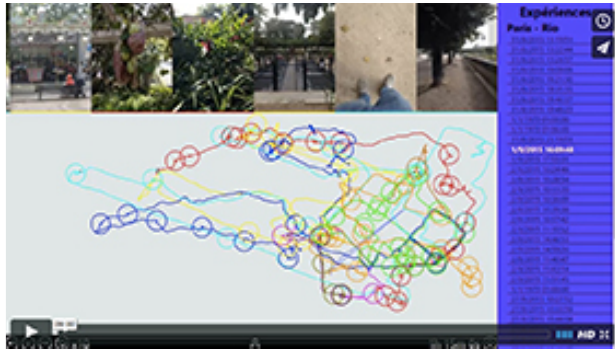
Figure 1. Example of combined simultaneous walks and tracks between several walkers in Rio de Janeiro’s Jardim Botatnico and the Jardin du Luxembourg in Paris, Fictions & interactions Team &